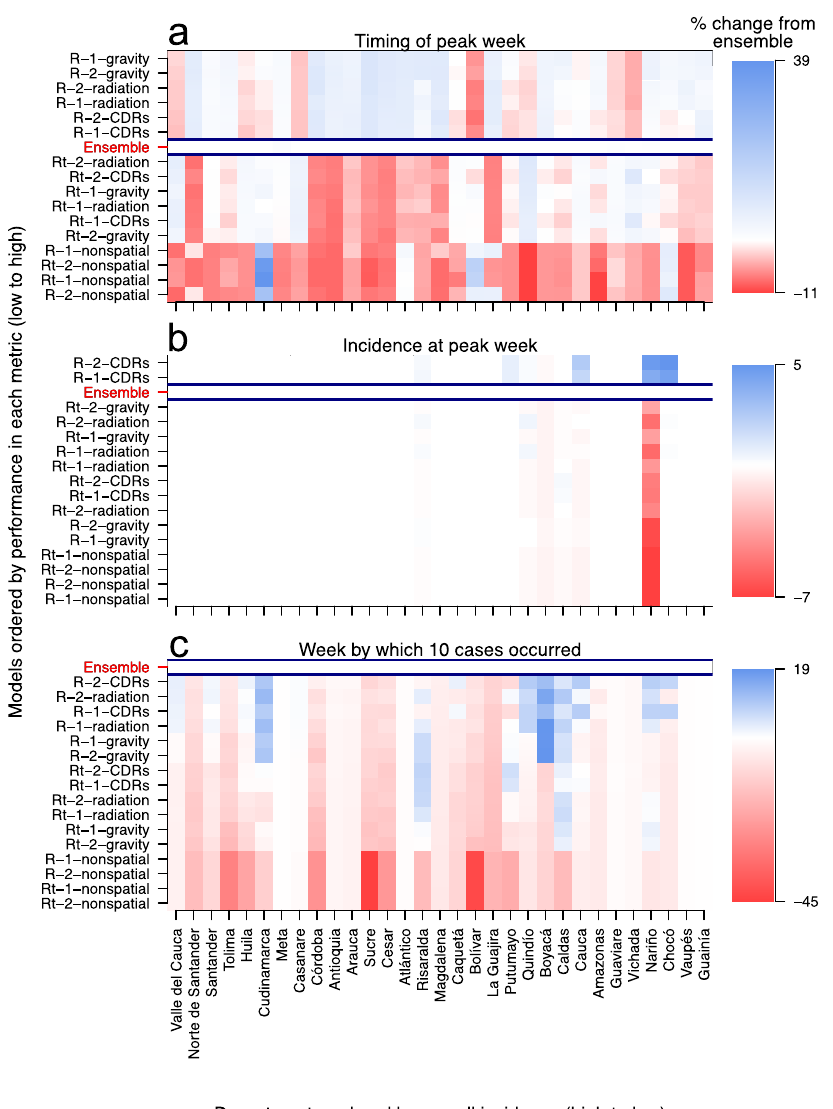
Fig. 5 Model-speci fi c forecast scores are relative to equally weighted ensemble model for each department and forecasting target. a Timing of peak week (within 2 weeks). b Incidence at peak week. c Onset week, or the week by which ten cumulative cases occurred. Forecast scores are averaged over the department. Models are ordered on the y -axis by average forecast score for each forecasting target, with model names abbreviated in the same manner as Fig. 4. Departments are ordered on the x-axis from high to low for overall incidence. In the heat plot, blue indicates individual model performed better than the ensemble model in a given department, red indicates individual model performed worse than ensemble model, and white indicates individual model performed roughly the same as the ensemble